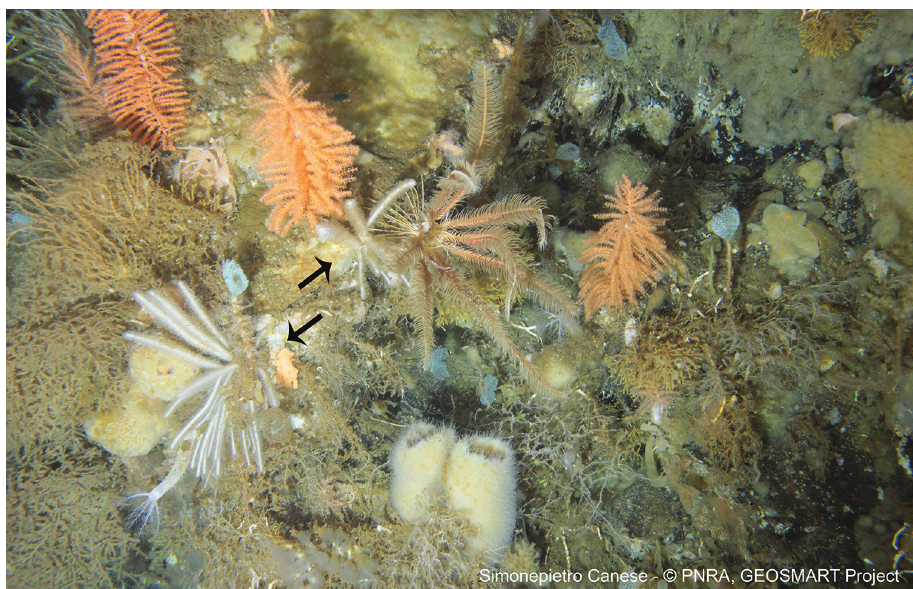
Figure 6. ROV video frame reporting the presence (arrows) of the species Lycopodina cf. vaceleti (van Soest & Baker, 2011) at Terra Nova